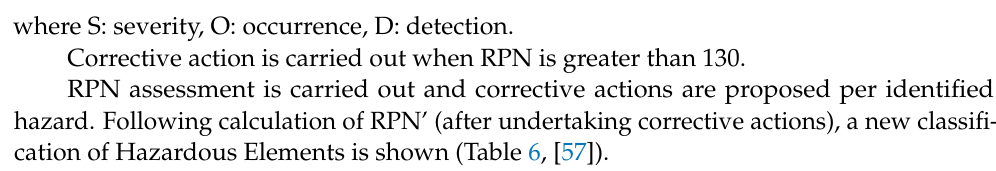
Table 6. FMEA Table of hazardous processing methods for food products for the receiving stage. Defective